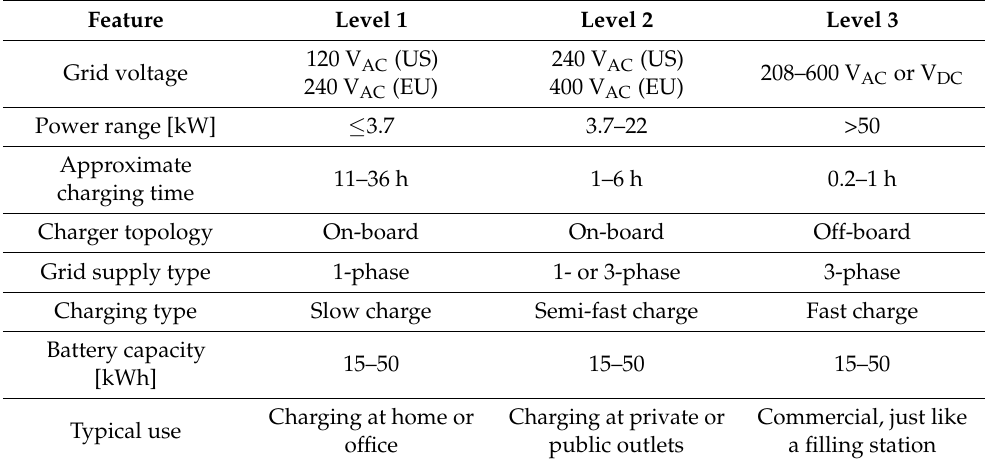
Table 1. Main features of EV battery chargers